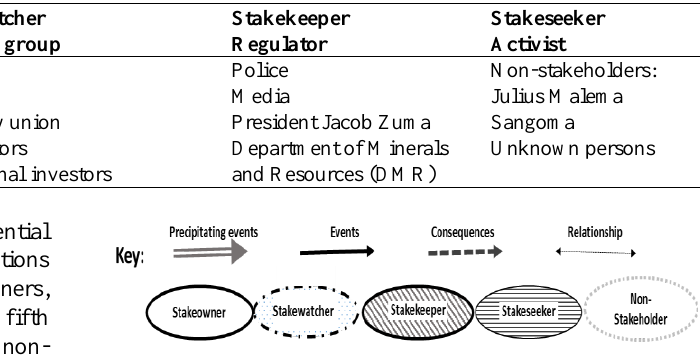
Figure 2: Legend used in the Lonmin stakeholder model Period 1 to 10